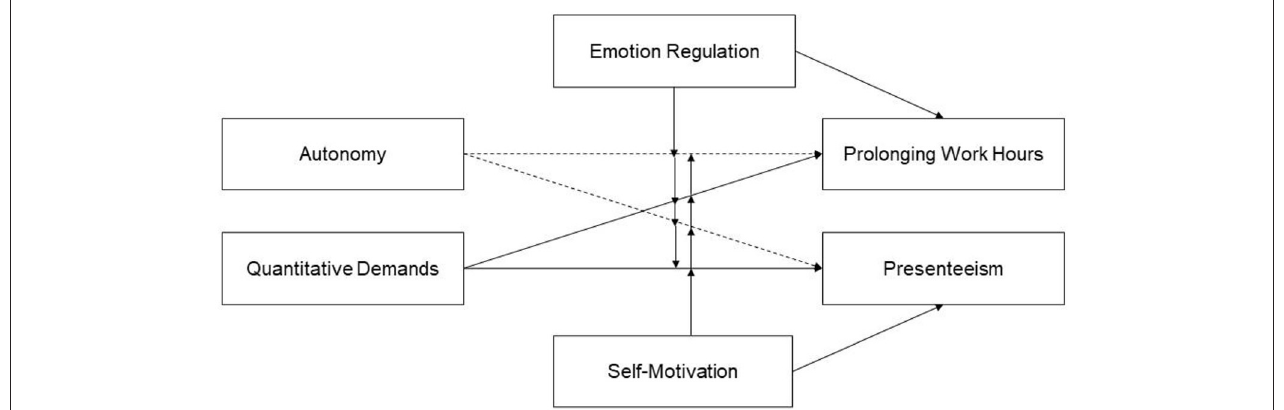
FIGURE 1 | Conceptual research